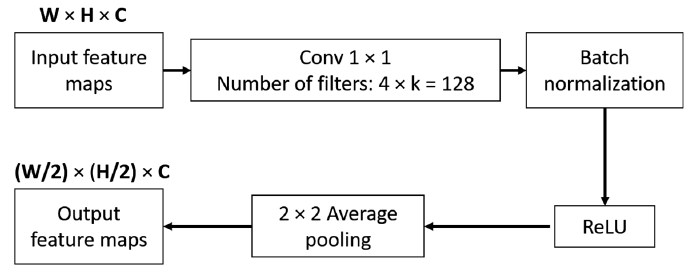
Figure 3. Transition layer design.